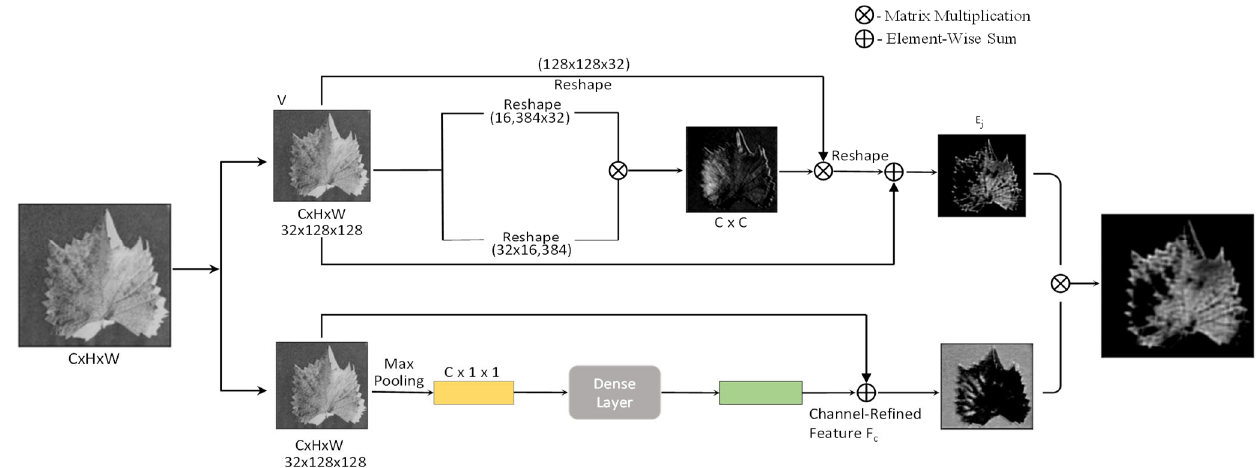
Figure 3. Channel Attention